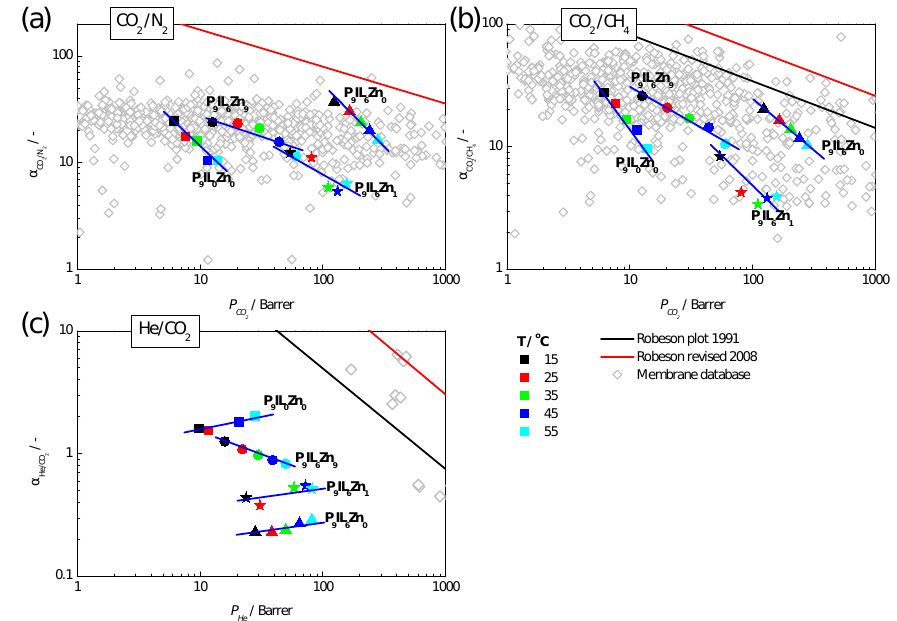
Figure 6. Positions of the composite PIL/IL/Zn 2+ materials on the CO 2 /N 2 ( a ), CO 2 /CH 4 ( b ) and He/CO 2 ( c ) Robeson’s plots. The ideal separation performances of reported membrane materials are presented for comparison and are freely available from the Membrane Society of Australasia [78]. Blue solid lines are for guiding the